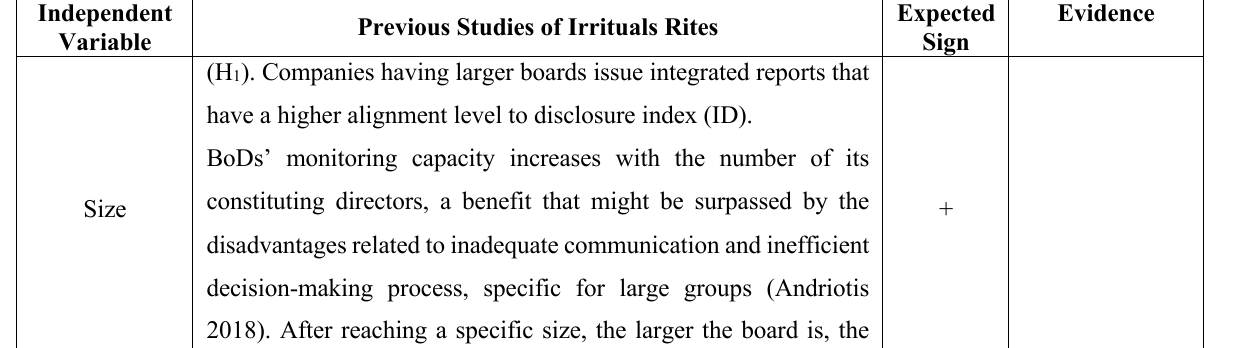
Table 6. Framework and hypotheses